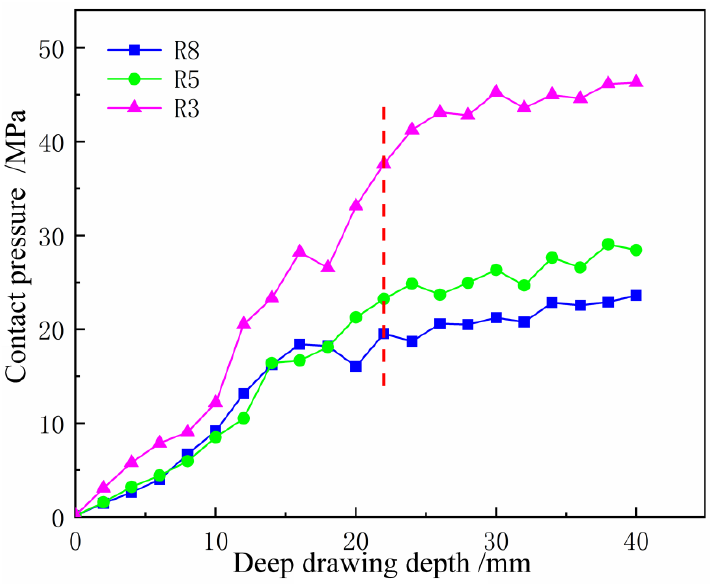
Figure 14. The drawing depth – contact pressure curve under different die fillets.